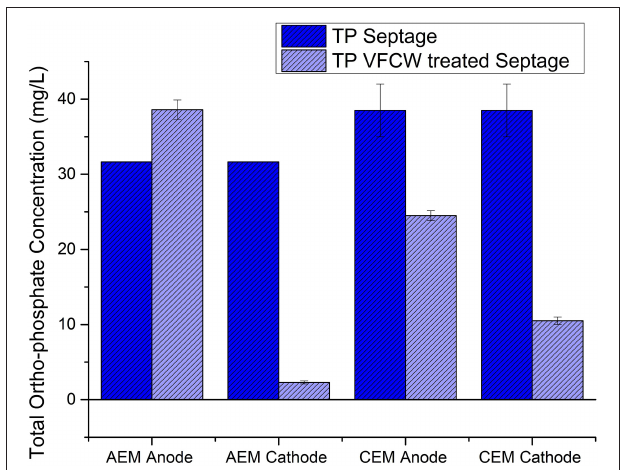
FIGURE 6 | Variation in ortho-phosphate concentration of septage/blackwater after 90min of electrolysis in anode and cathode chamber recirculation in ECR with AEM and ECR with CEM.